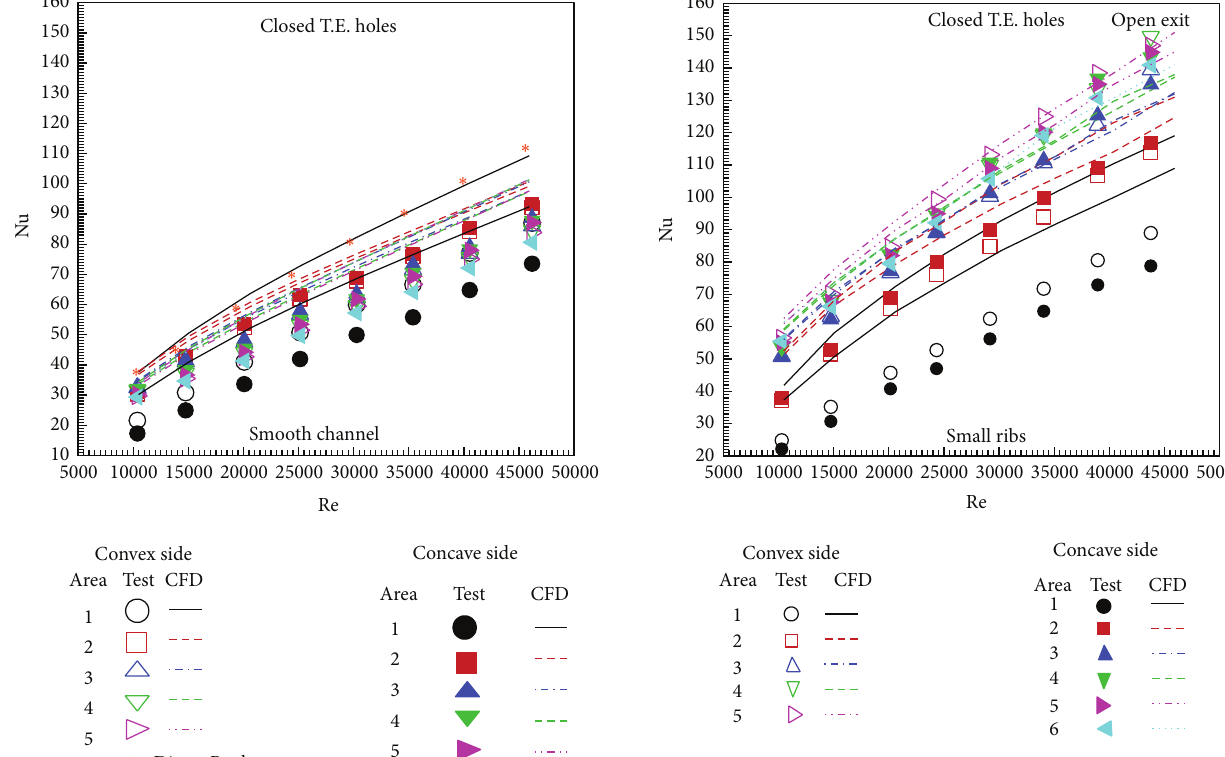
Figure 11: Comparison of the measured and CFD heat transfer results in the rib-roughened channel on the convex and concave walls for the case of closed trailing-edge hole and open channel